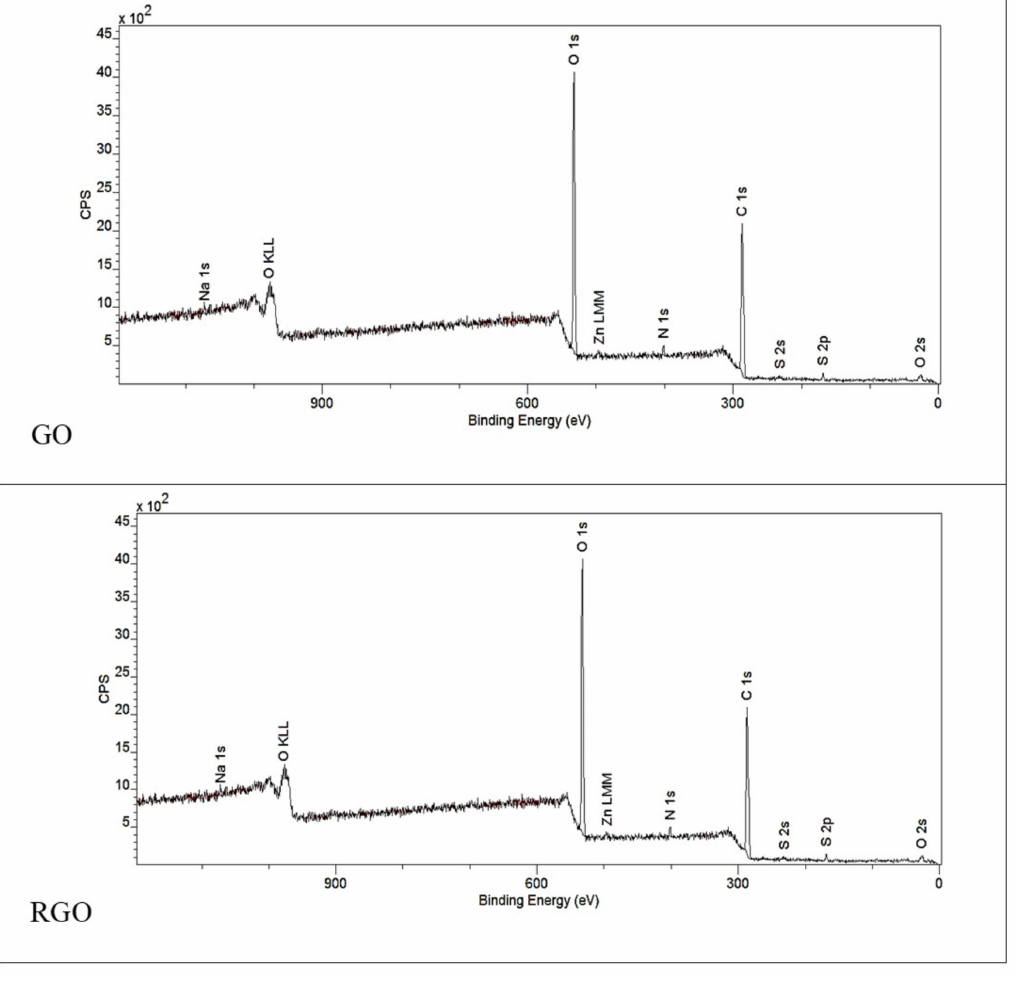
Figure 2. XPS survey spectra of GO and RGO.